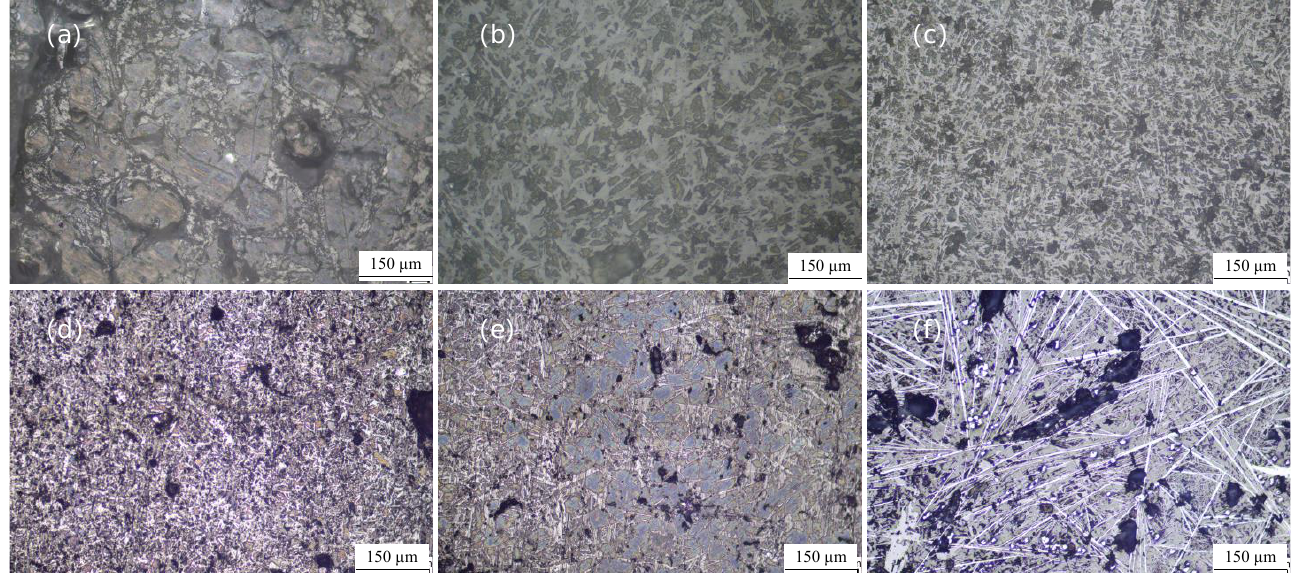
Figure 1. Slag mineral-phase structure. ( a ) Refining slag +0% CeO 2 ; ( b ) Refining slag +5% CeO 2 ; ( c ) Refining slag +8% CeO 2 ; ( d ) Refining slag +10% CeO 2 ; ( e ) Refining slag +15% CeO 2 ; ( f ) Refining slag +20% CeO 2 .